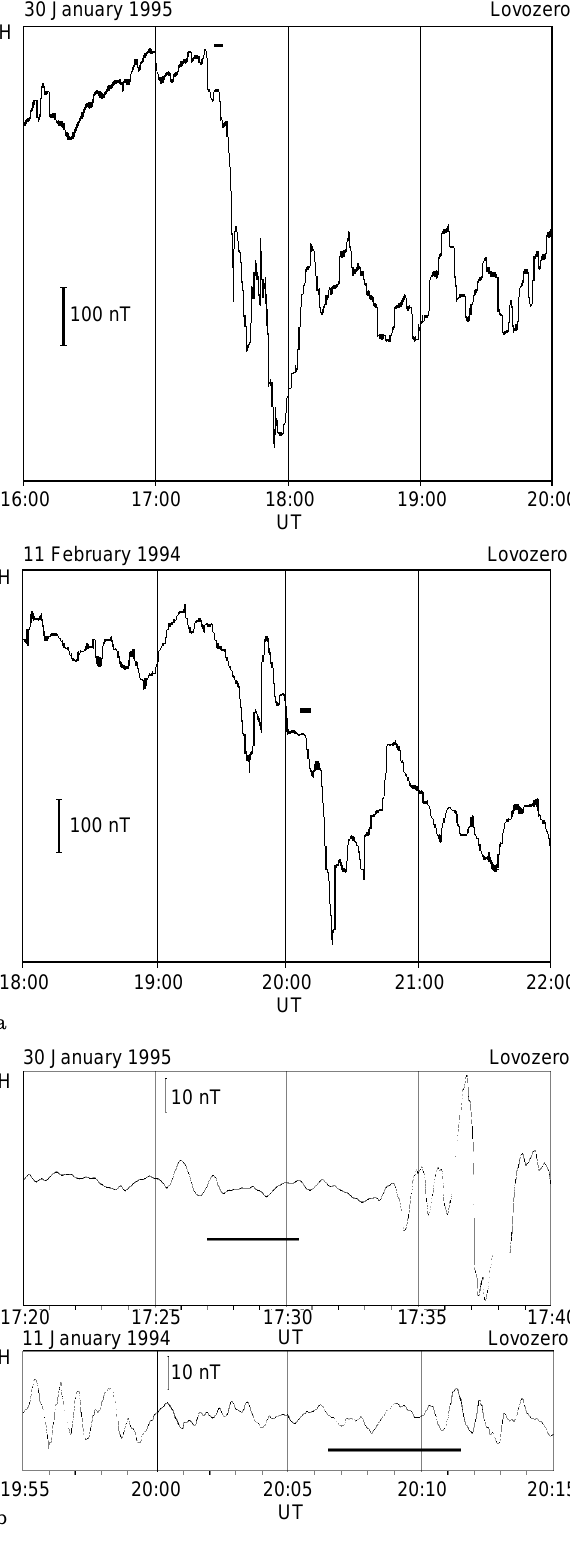
Fig. 1a,b. Variations of the H-component of geomagnetic field in Lovozero. a Standard magnetograms showing the level of geomag- netic activity. b Rapid-run magnetograms. The intervals of observa- tion of multiple auroral arc structures (MAAS) are shown with horizontal